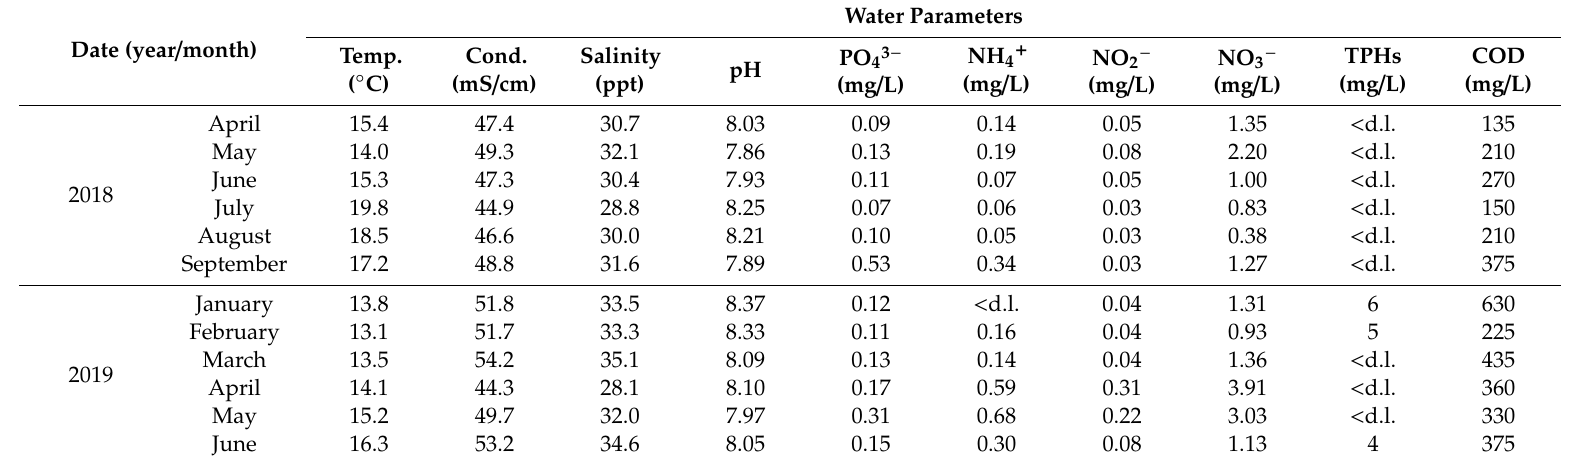
Table 1. Water characterization of the seawater marina of the Porto Cruise Terminal along the experimental time (2018 /